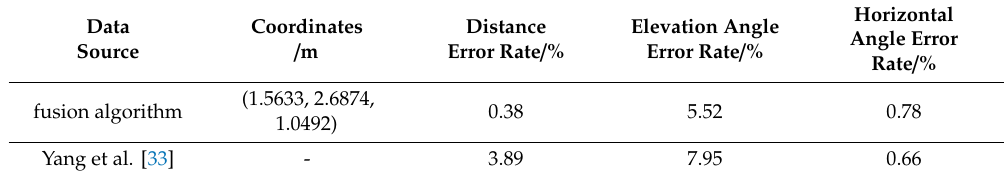
Table 9. Contrast experimental